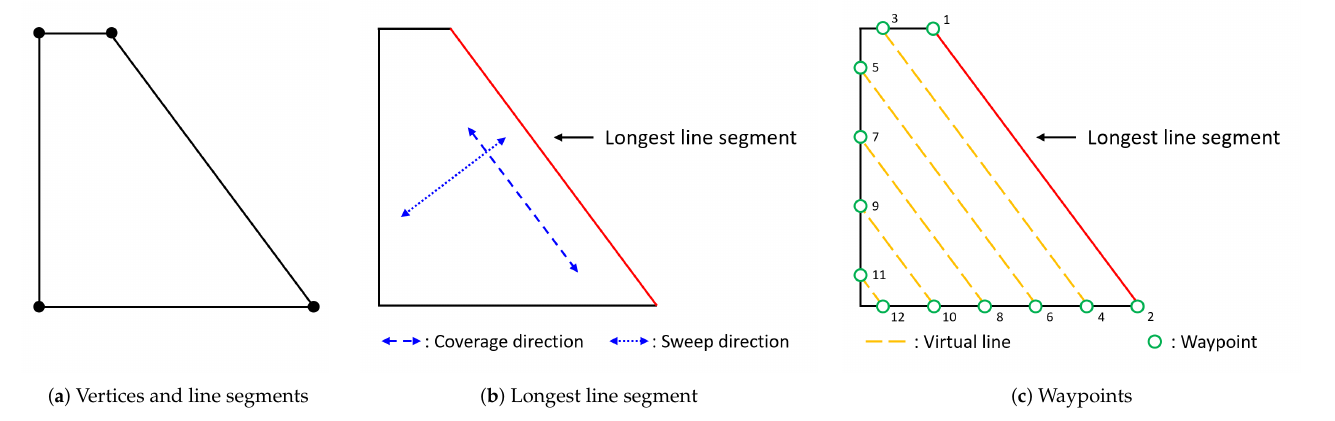
Figure 3. Graph building